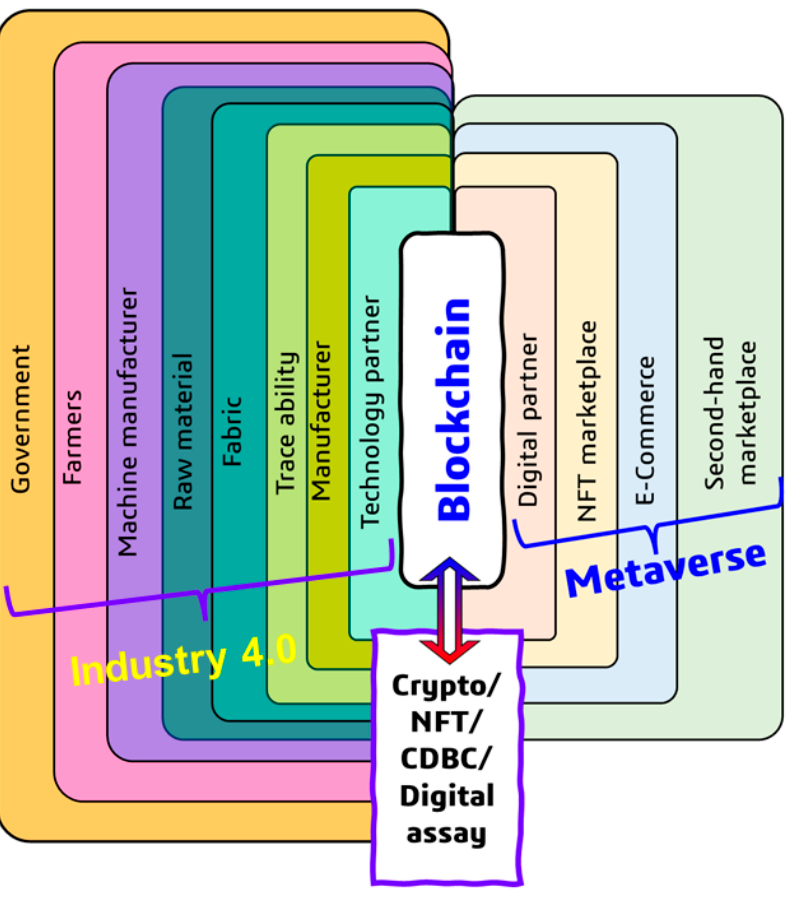
Figure 4. Multitude business ecosystem.